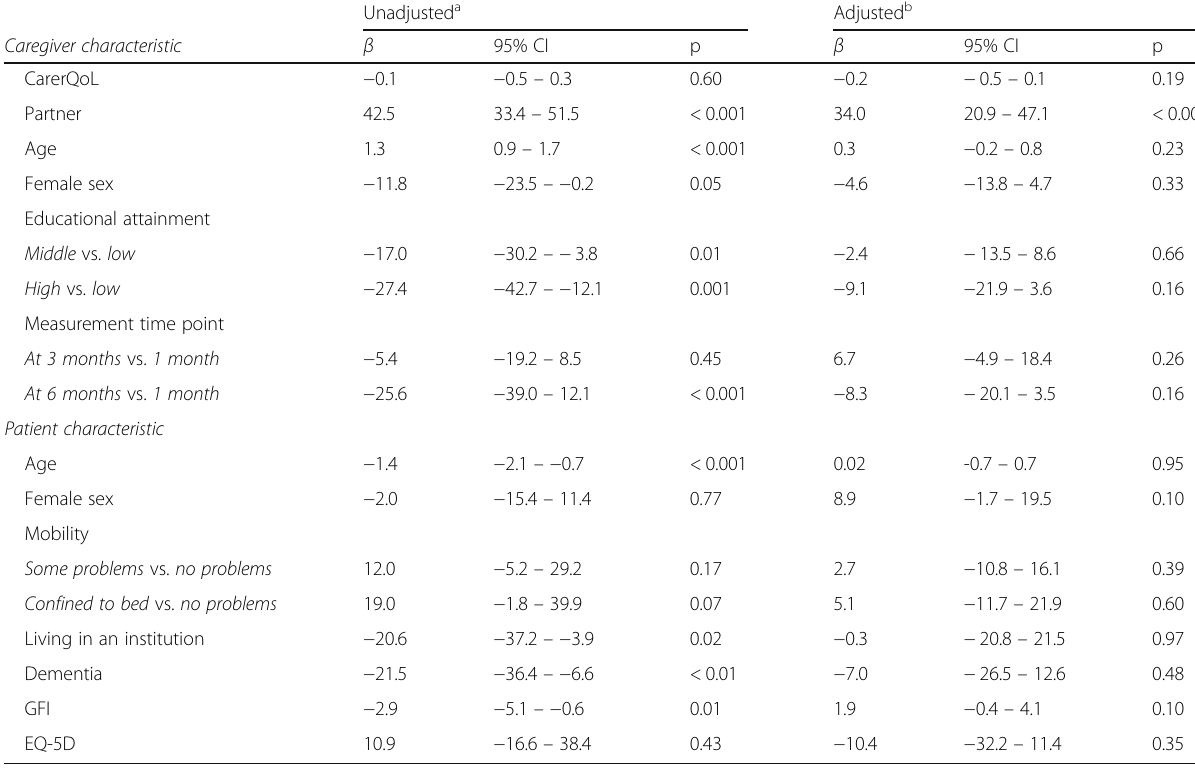
Table 3 Univariate- and multivariable linear regression results for association with intensity of provided informal care of informal